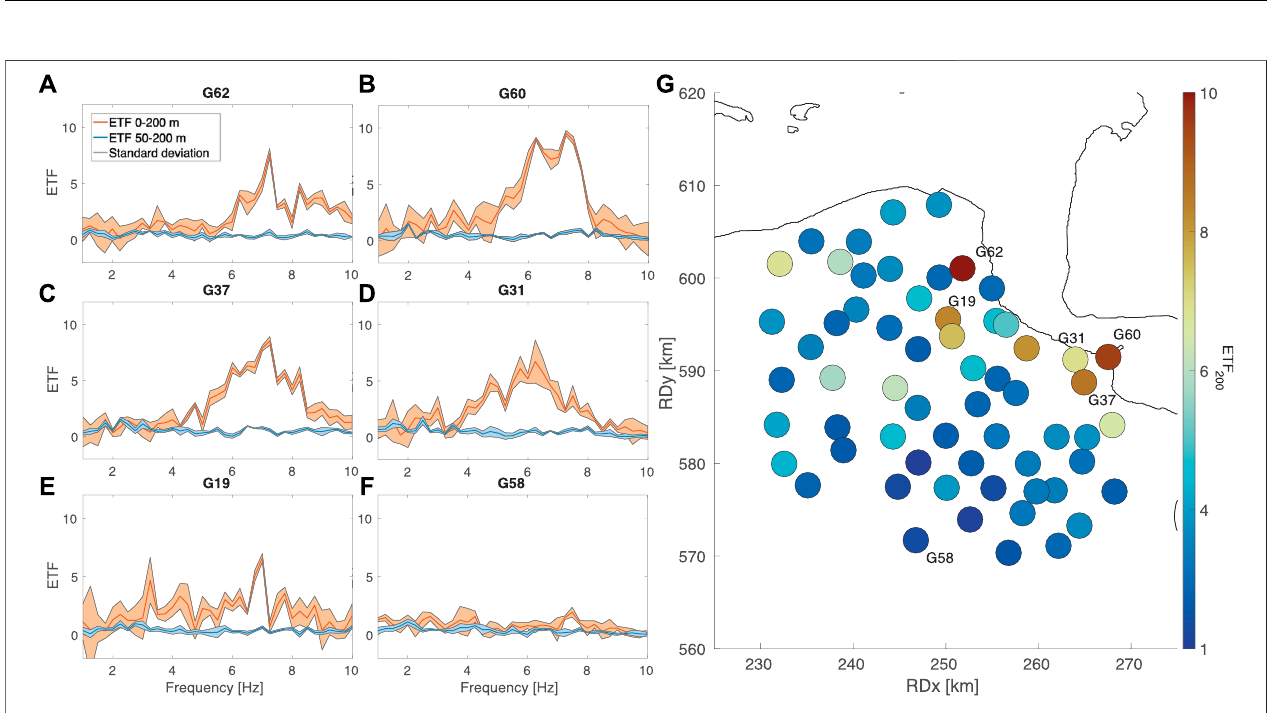
FIGURE 7 | (A) Each panel depicts the empirical transfer functions (ETFs) between the seismometer at 200 m depth and the surface (red) and standard deviation (paleredarea)forsitesG19,G31,G37,G60,andG62,displayingthefrequency-dependentampli fi cation.ThebluelinesillustratetheETFsbetweentheseismometersat 200 m and 50 m. Borehole G62 additionally depicts the ETF between the surface and 50 m seismometer (gray). Borehole G58 is added as example of a borehole site with no ampli fi cation measured. (B) Spatial distribution of the peak amplitudes from the ETF for 60 borehole station sites.